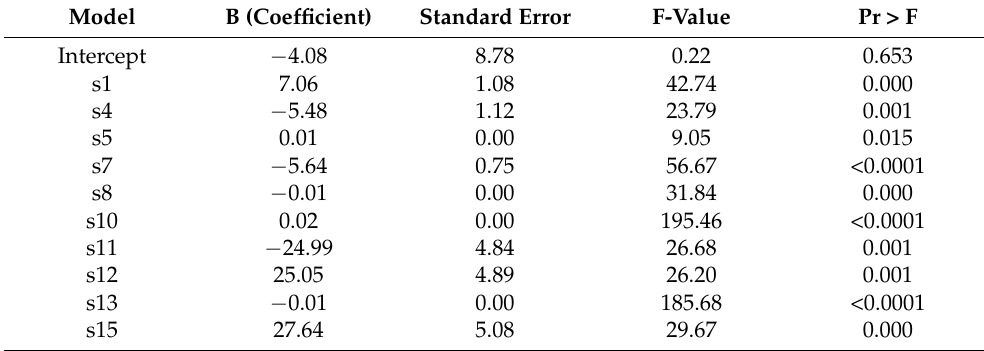
Table 8. Multiple linear regression analysis of meteorological factors and grain crude fat content.